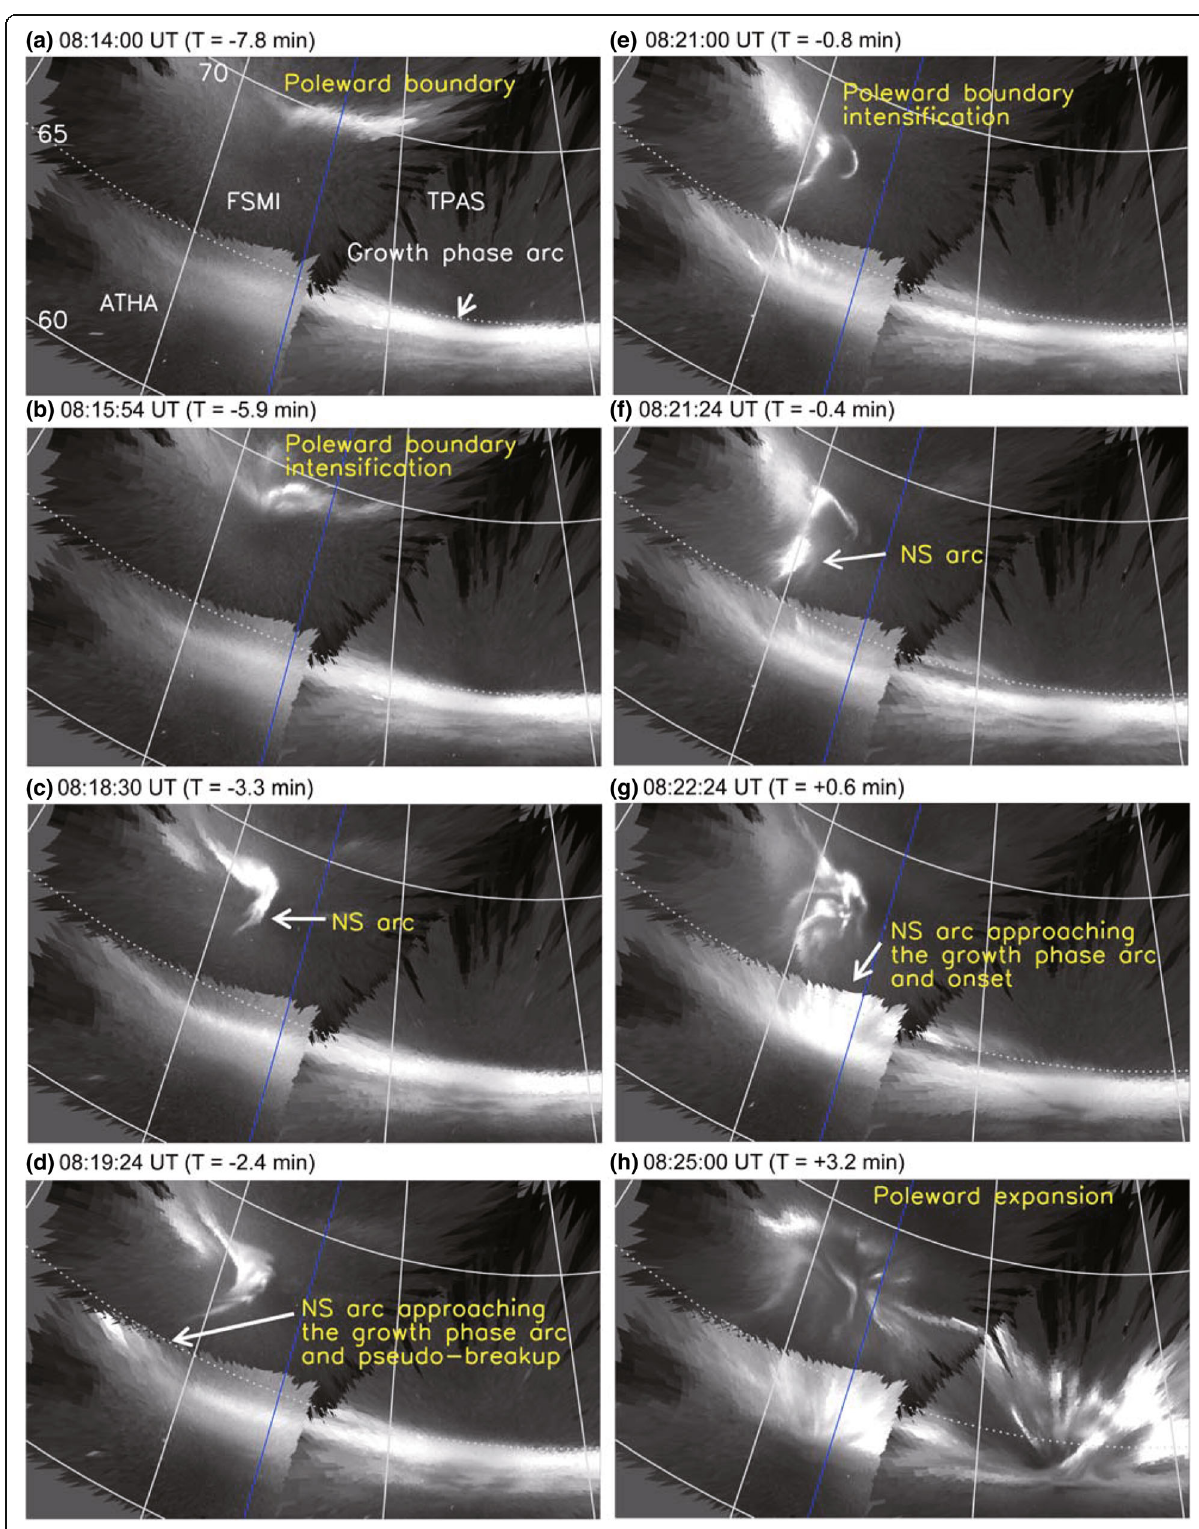
Fig. 7 a – h Observed high-latitude aurora moving equatorward. Auroral images observed at different sites are mapped to the ionosphere altitude. (Adapted from Nishimura et al.